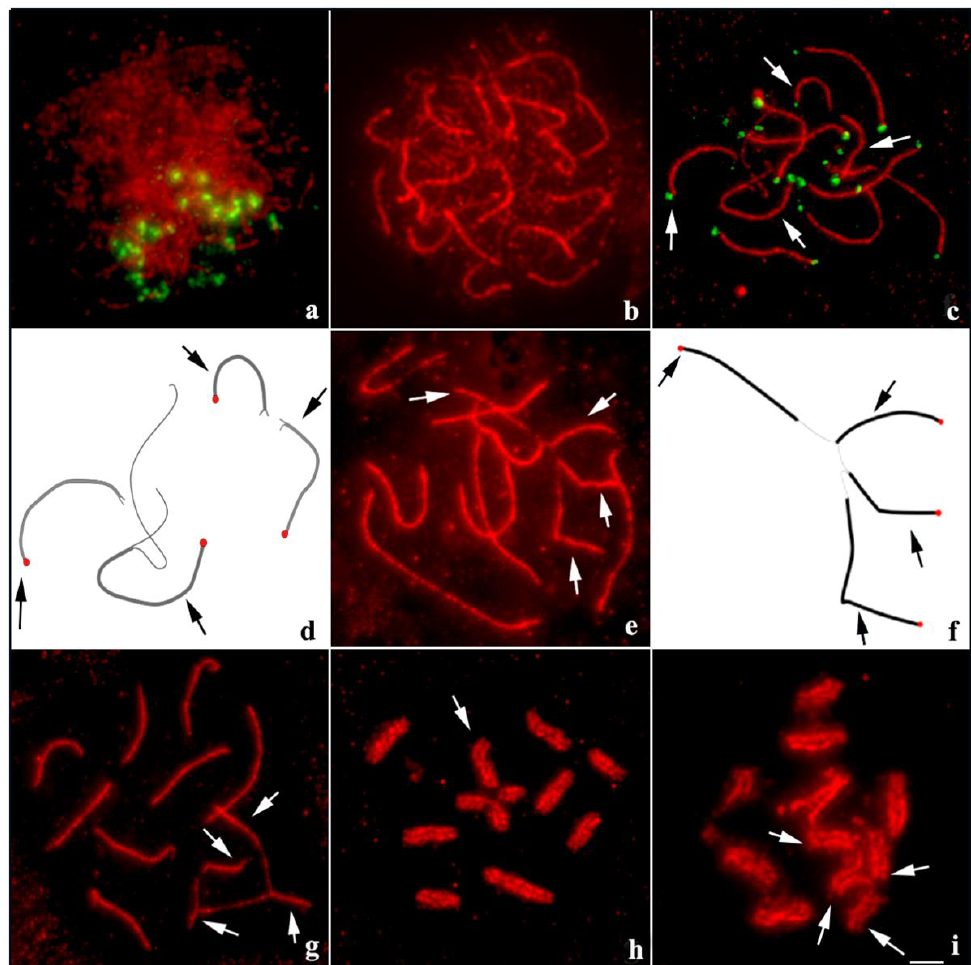
Figure 2. Organization of the synaptonemal complex in T. maranhensis . Immuno-FISH with SMC3 (red) and telomeres (green) at “ a ” and “ c ” . ( a ) Leptotene/zygotene transition; SMC3 axes and telomeres arranged in bouquet configuration. ( b ) Late zygotene; synaptic and asynaptic segments of the synaptonemal complex were characterized by the presence, respectively, of thicker and thinner SMC3 filaments. ( c ) Early pachytene (arrows indicate asynaptic regions of the quadrivalent). ( d ) Schematic representation of SMC3 axes (black) and telomeres (red) pointed by arrows in “ c ”. ( e ) Intermediate pachytene (arrows indicate regions of the quadrivalent in synapse process). ( f ) Schematic representation of the SMC3 axes (black) indicated by the arrows in “ e ”. ( g ) Late pachytene (arrows indicate regions of the quadrivalent in synapse process). ( h ) Metaphase I (arrow indicates the quadrivalent). ( i ) Early anaphase I (arrows indicate quadrivalent components initiating segregation). Bar: 10 µm.